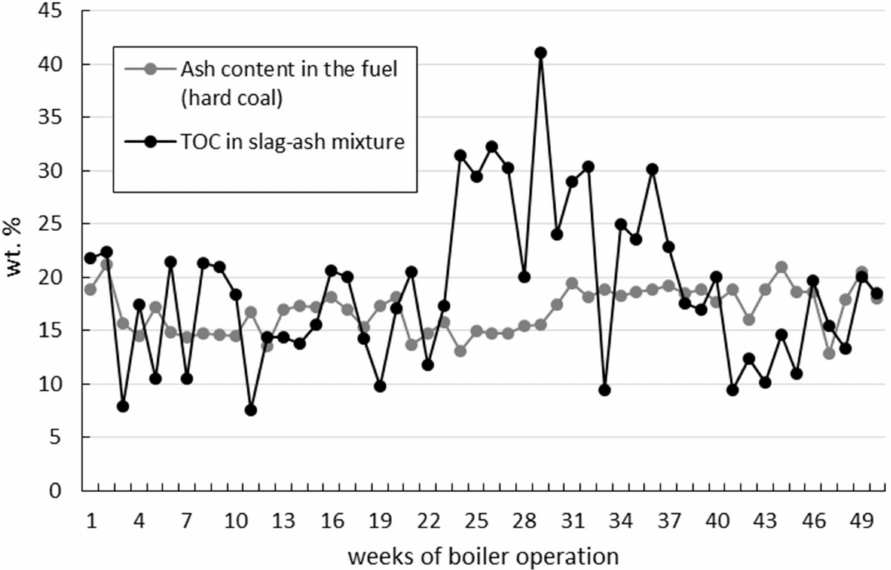
Figure 7. Ash content of the fuel and total organic carbon (TOC) in slag-ash mixture measured weekly.